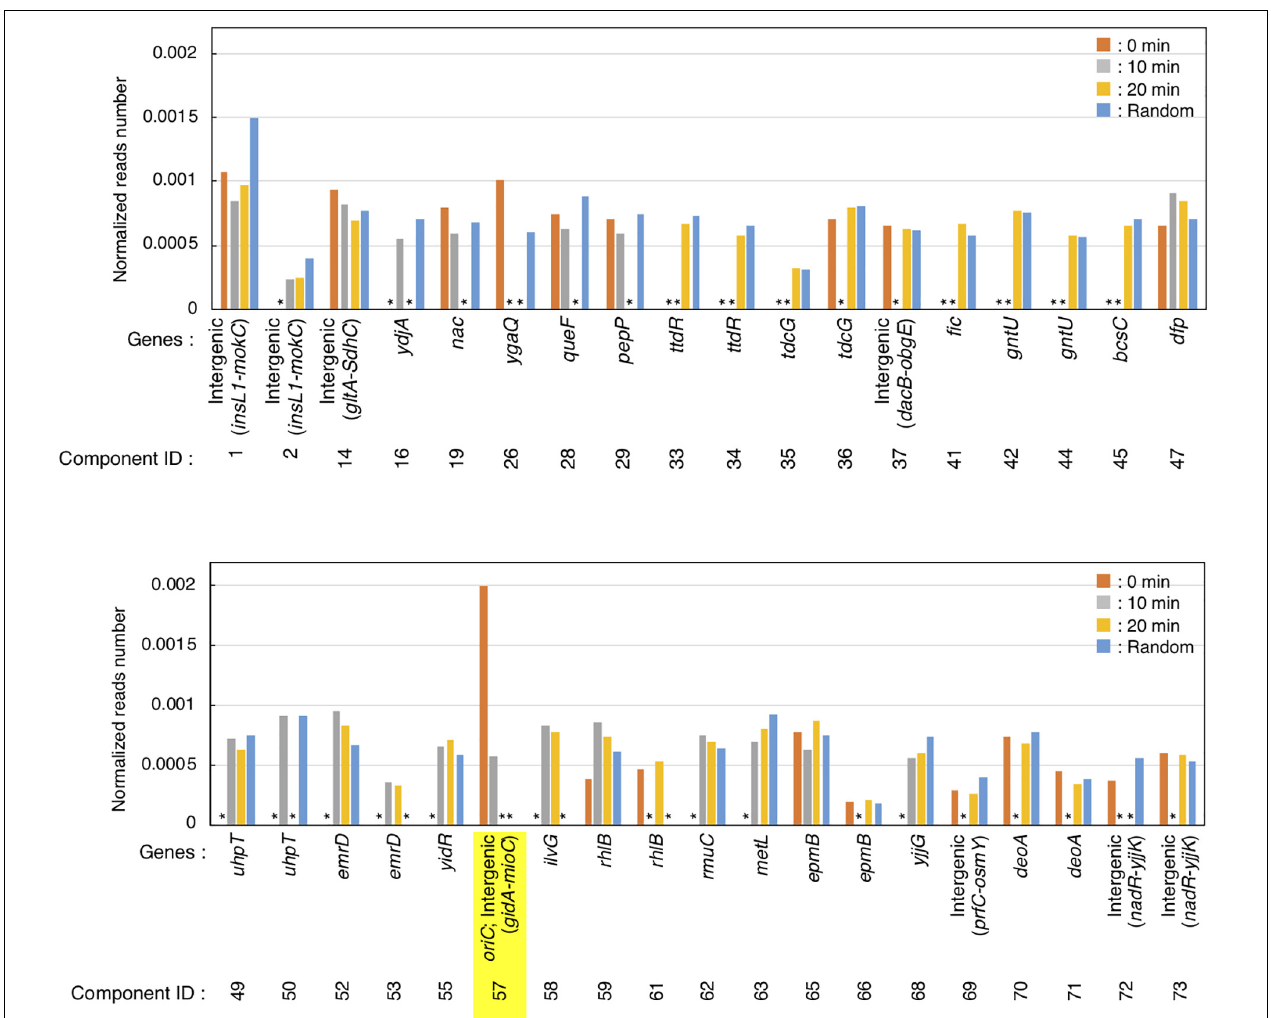
FIGURE 4 | Preferential IHF binding at oriC at replication pre-initiation stage. Highest IHF-binding peaks at each timepoint are listed as bar charts. Y-axis indicates the normalized reads number which means the relative read numbers of each component divided by the total mapped reads numbers of the reference genome at each timepoint. Stars (*) indicate “lower than the threshold values,” which means that the component was not identified as highest IHF binding peaks at each